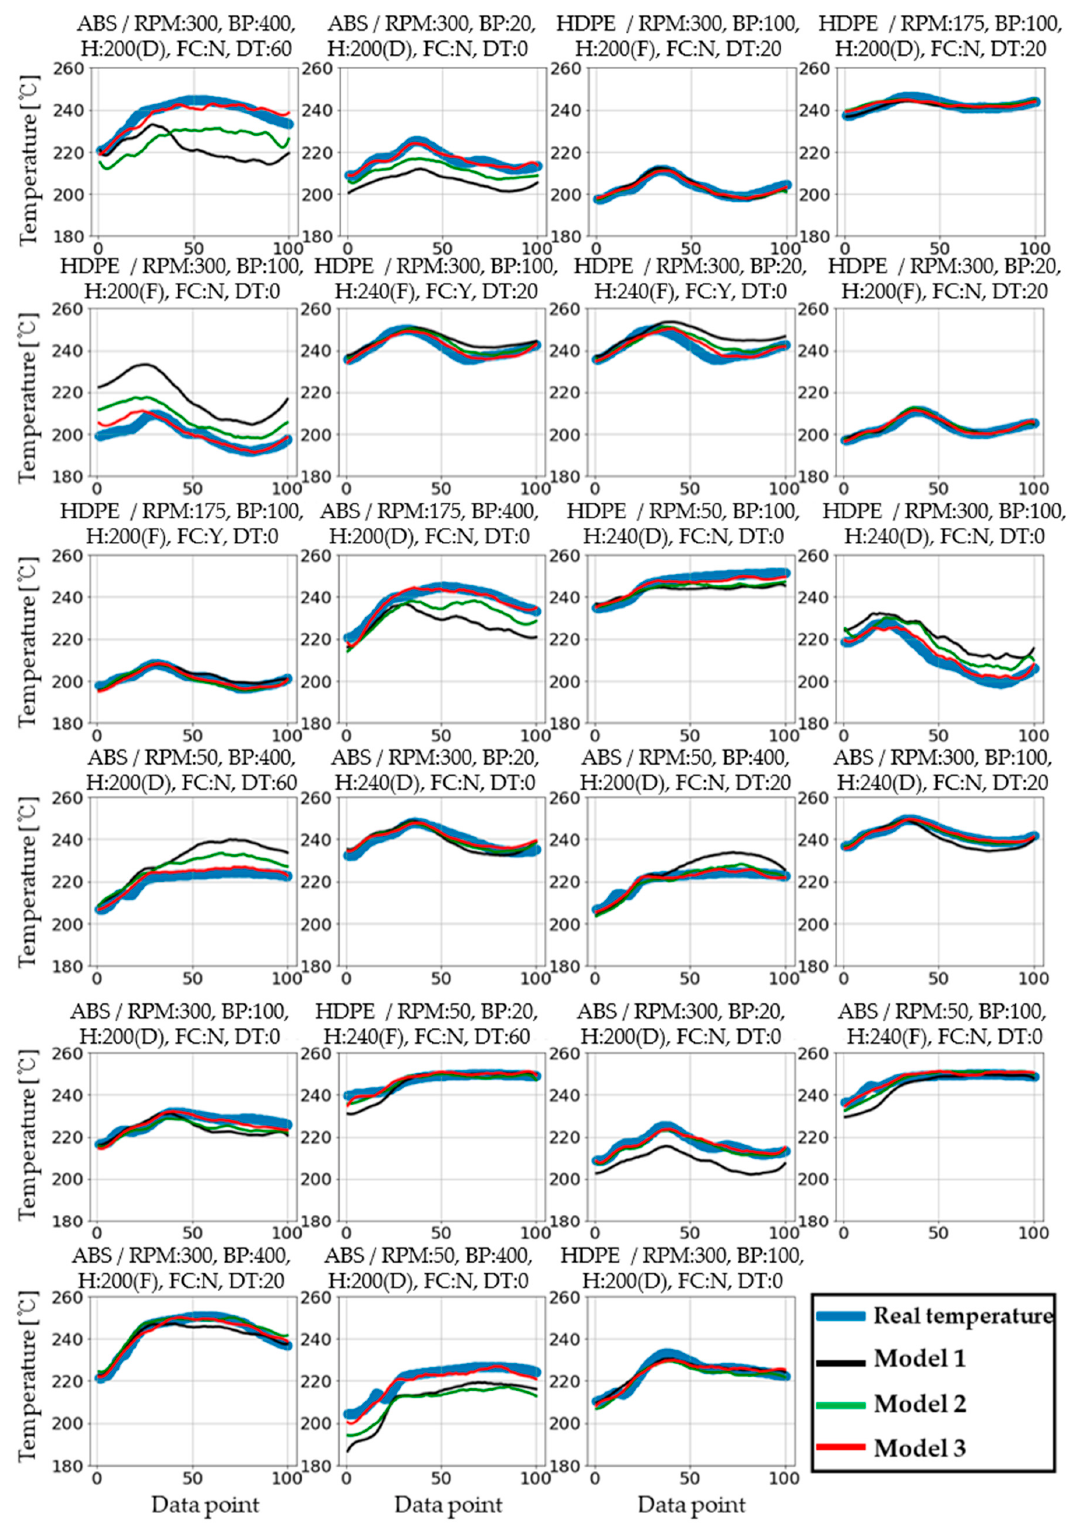
Figure 11. Temperature data for 23 randomly selected values and temperature prediction graphs of the three models. The horizontal axis represents the temperature points. Physically, this refers to the relative distance from the nozzle in the barrel chamber. (Plot title: material/screw RPM, back pressure in bar, heater temperature in °C (heater profile D: decrease, F: flat), forced cooling (Y/N), dwell time in s).